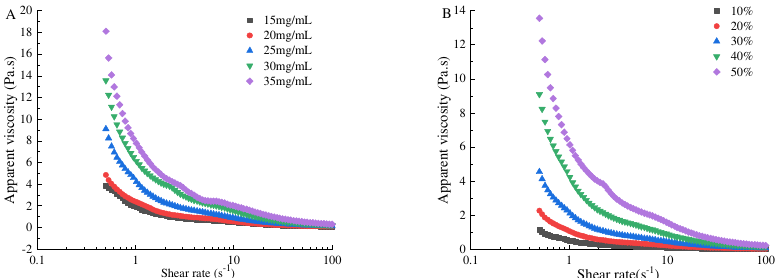
Figure 9. The effect of particle concentration ( A ) and oil phase volume fraction ( B ) on the apparent viscosity properties of the Pickering emulsion. (( A ) is the apparent viscosity of Pickering emulsion prepared at different concentrations of SPI and maltose, ( B ) is the apparent viscosity of Pickering emulsion prepared at different oil phase volume fraction.).